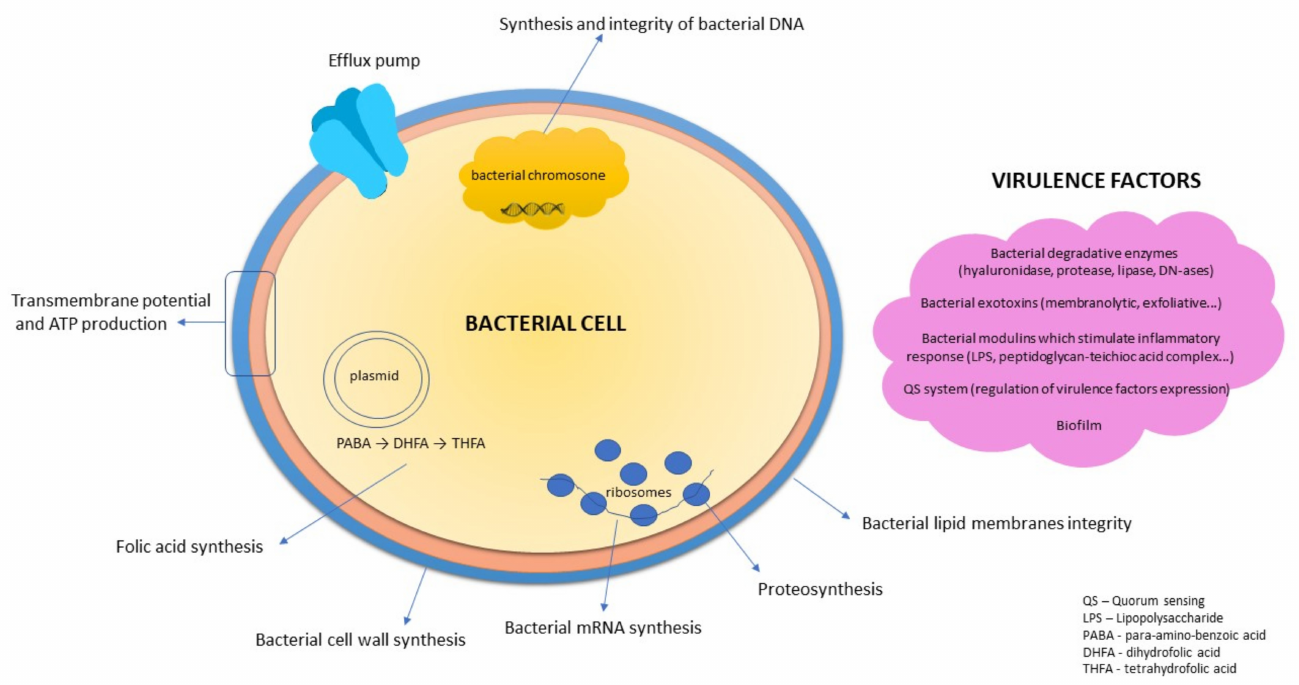
Figure 1. Targets for antibacterial compounds. (Figure according to Slobodn í kov á , 2019)